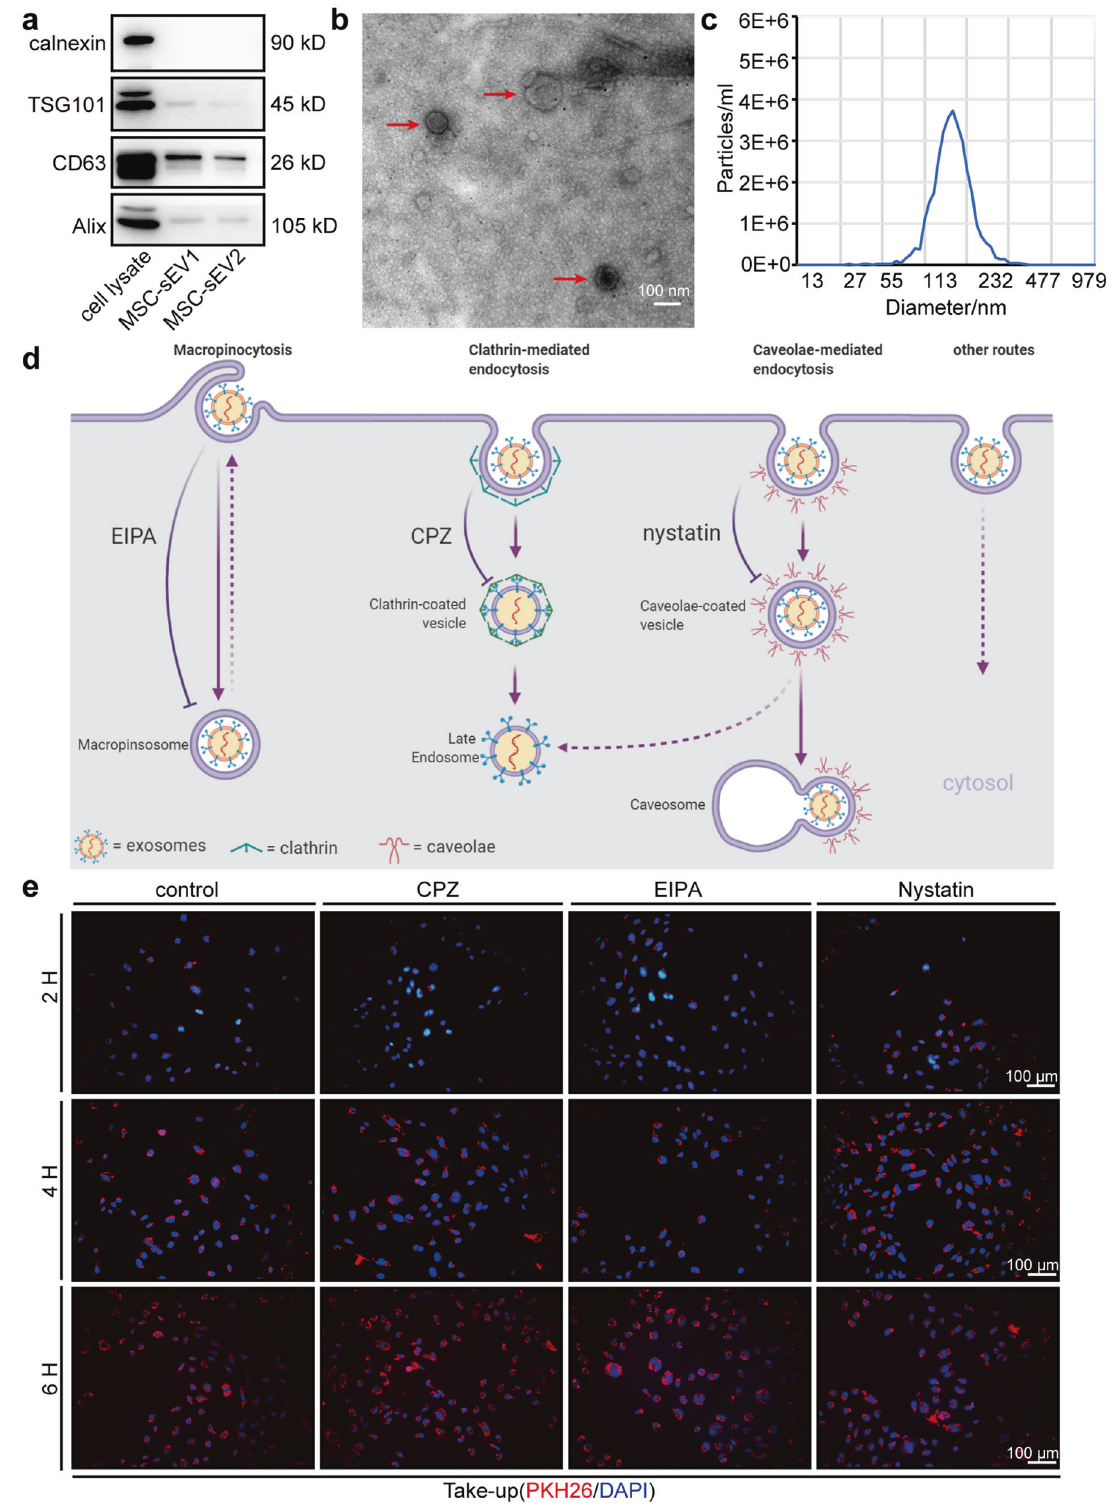
Fig. 1 b Transmission electron microscopic images of MSC-sEV (scale bar, 100